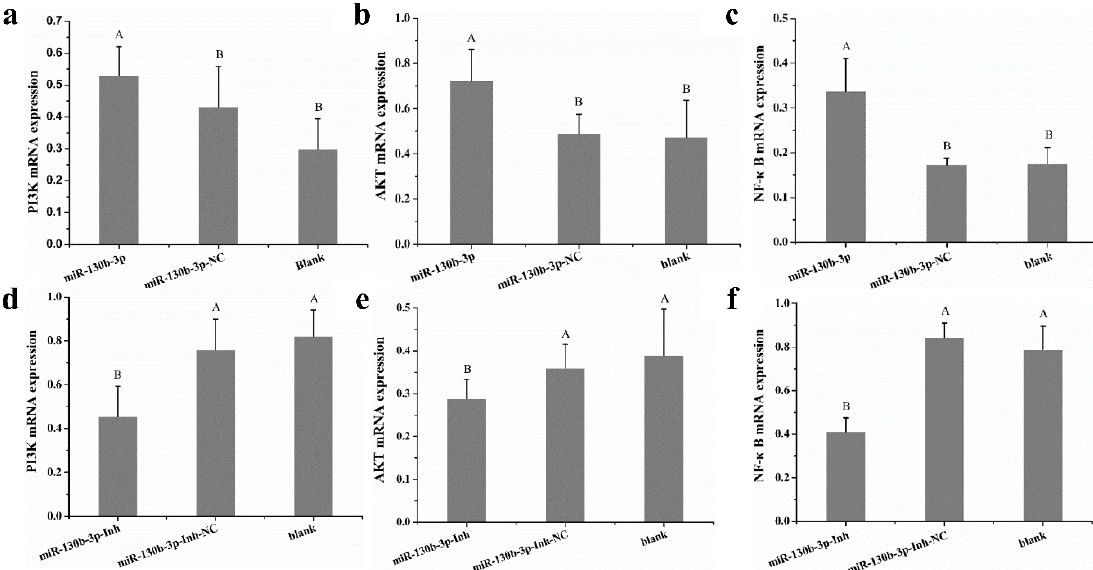
Figure 7. miR-130b-3p activates PI3K/AKT/NF-κB pathway. DF-1 cells cultured in six-well culture dishes were transfected with miR-130b-3p or miR-130b-3p-NC. After 48 h, the expressions of PI3K ( a ), AKT ( b ), and NF-κB ( c ) were examined by RT-qPCR. Similarly, DF-1 cells transfected with miR-130b-3p-Inh or miR-130b-3p-Inh-NC were incubated for 48 h. Then, the expressions of PI3K ( d ), AKT ( e ), and NF-κB ( f ) were examined through RT-qPCR. The relative expressions of PI3K, AKT, and NF-κB were normalized to GAPDH. Each experiment group contained at least three duplicates. Each duplicate was measured at least three times. Values are expressed as mean ± SD. Bars with different superscripts letters show marked differences ( p < 0.01).